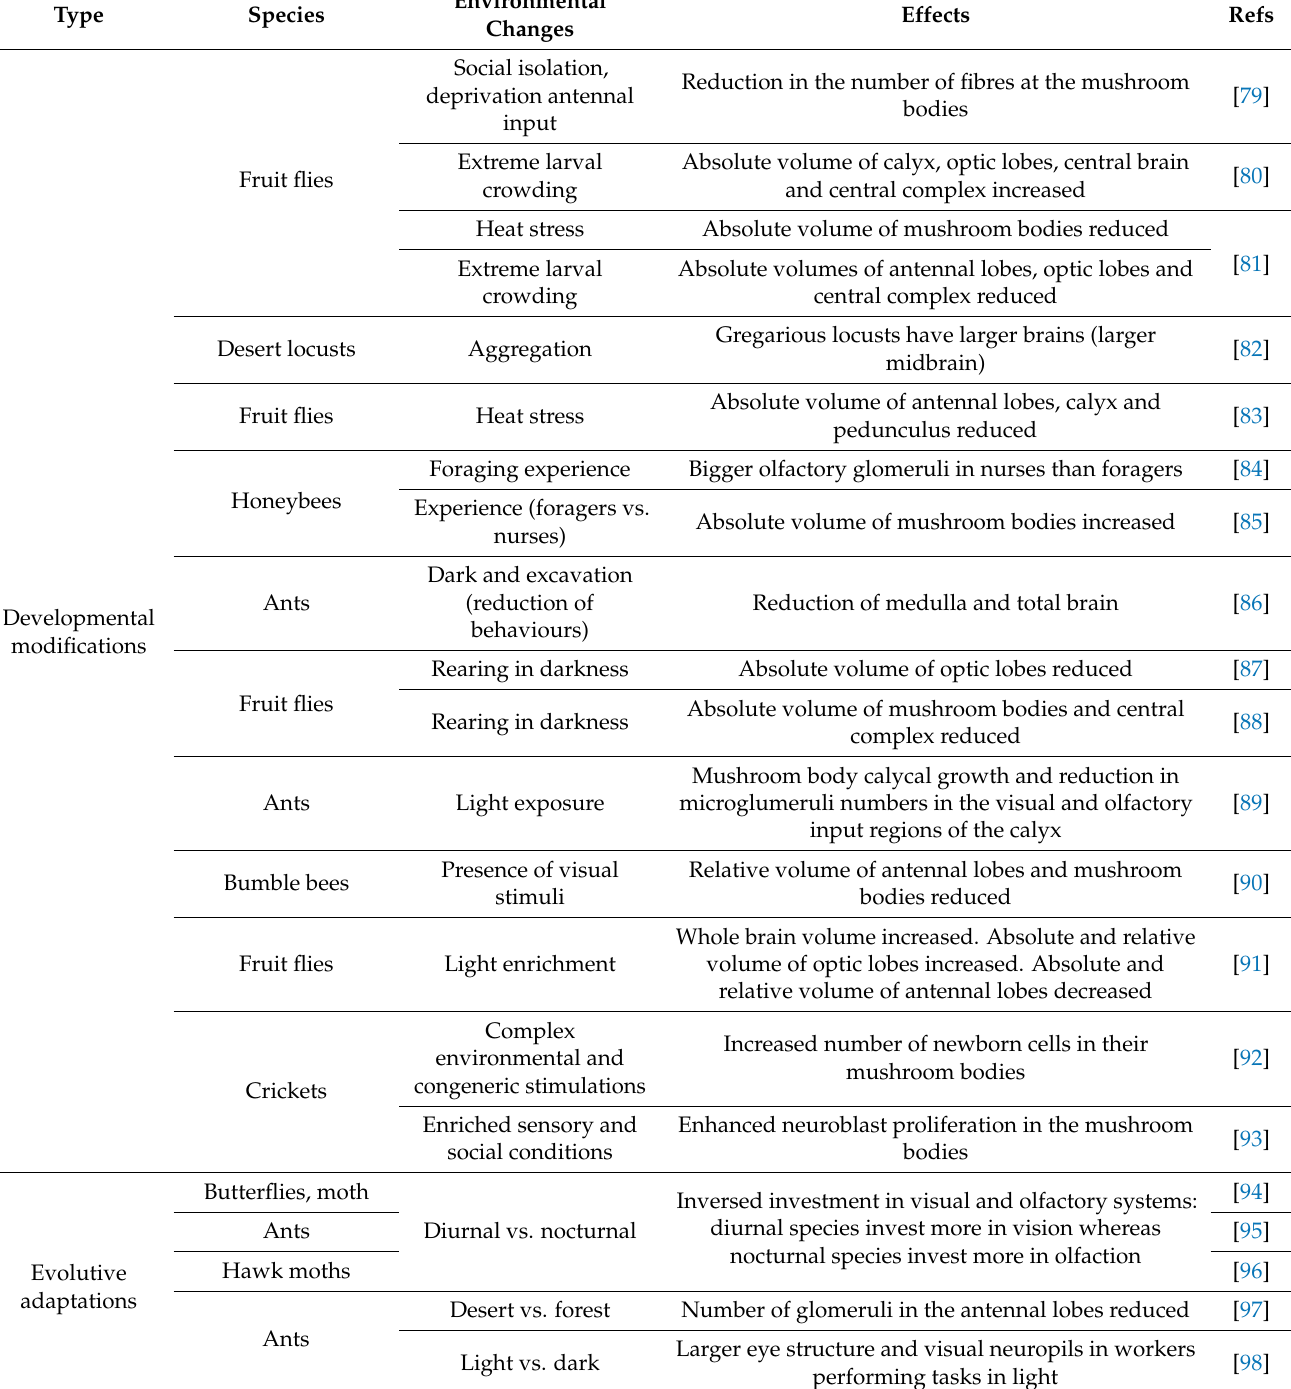
Table 1. Summary of studies investigating effects of environment on brain size in